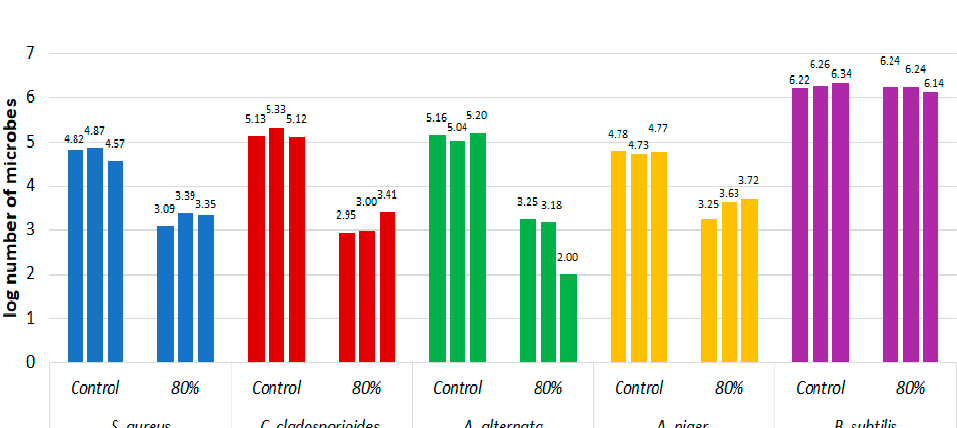
Figure 2. E ff ect of short-term exposure to 80% ethanol in the form of mist on the log decrease in the number of microorganisms on the model fabric compared with the control not treated with the disinfectant.